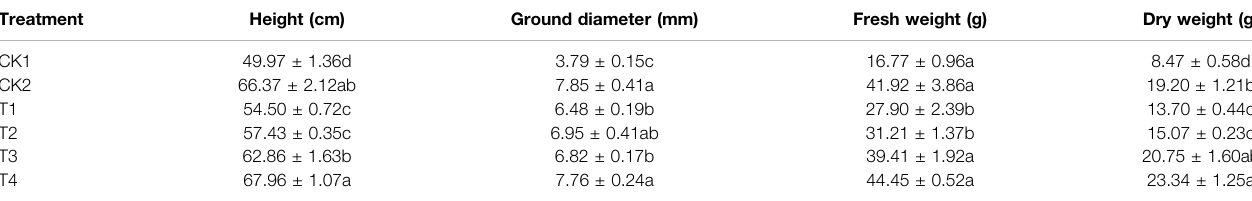
TABLE 3 | The in fl uence of different treatment methods on M. hupehensis Rehd. seedlings biomass. Treatment Height (cm) Ground diameter (mm) Fresh weight (g) Dry weight (g)